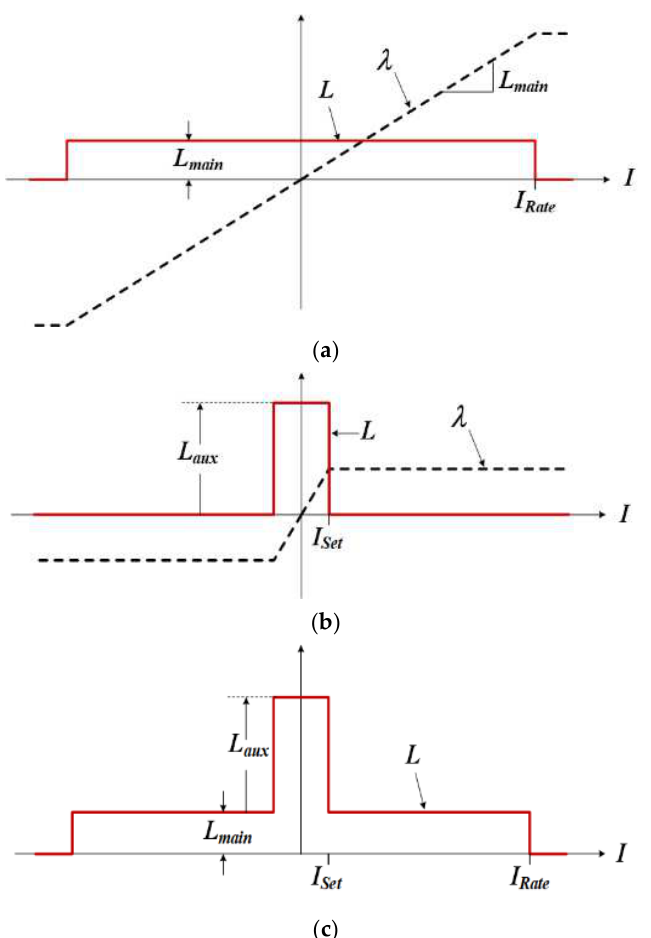
Figure 4. Simplified characteristics of a heterogeneous inductor. ( a ) Reactor characteristics with large rated capacity; ( b ) Reactor characteristics with small rated capacity; ( c ) Hybrid Reactor Characteristics.